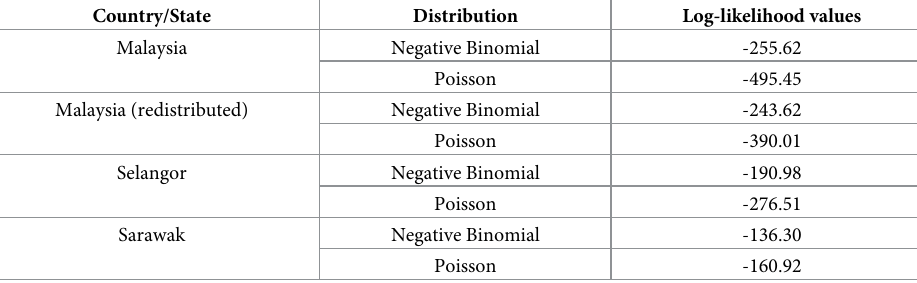
Table 6. Loglikelihood values of the NB and poisson likelihoods.